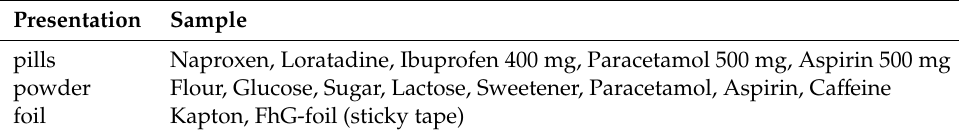
Figure 5. Picture and simplified schematic of the demonstrator system. Backscattering IR spectra are continuously recorded using the tunable EC-QCL and the HOT InAs / GaSb T2SL IR detector. As the sample platform rotates, di ff erent substances are illuminated and subsequently identified after comparison with the database. Table 1. Samples used in the demonstrator